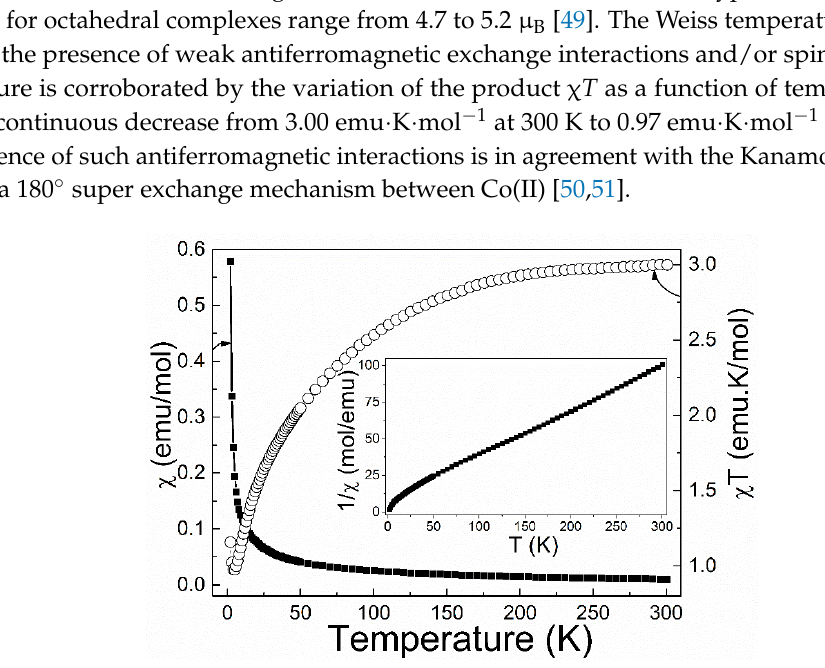
Figure 5. Variation of χ (black squares) and χ T (open black circles) as function of the temperature for Co(H 2 O) 2 PO 3 C–C 12 H 9 · H 2 O under 0.1 T.